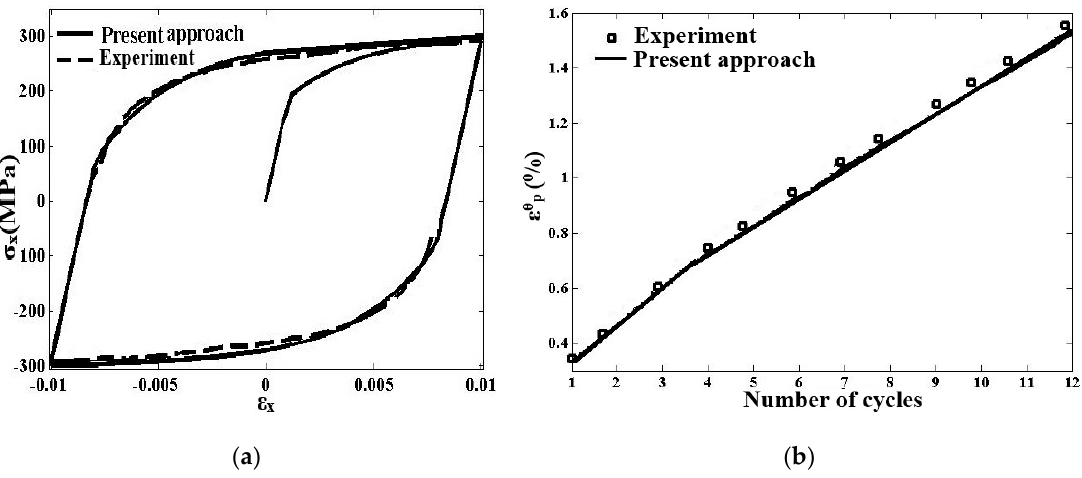
Figure 4. Comparisons of experimental results [32] and present approach; ( a ) axial stress/strain hysteresis curve for pipe made of CS 1026 under axial strain symmetric test. ( b ) Variations of plastic circumferential strain peak at each cycle be for pipe made of CS 1026 under axial symmetric cycling with strain amplitude of 0.5 % and constant internal pressure of 46.767 MPa.